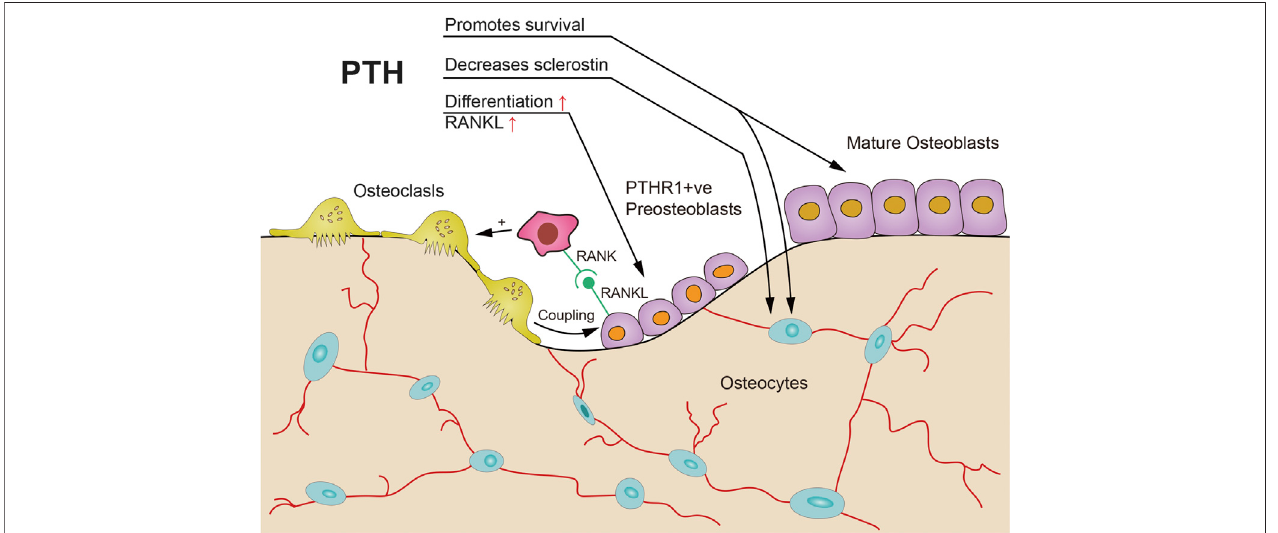
FIGURE 4 | Possible mechanisms of PTH anabolic action with prior osteoclast resorption. PTH could promote survival of osteoblasts and osteocytes, promote differentiation of osteoblast precursors, activation of osteoclasts that induce coupling activities, and inhibit sclerostin production by osteocytes [adapted from (Martin,